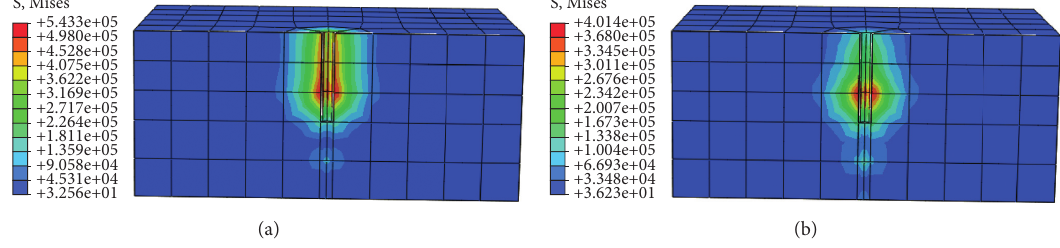
Figure 11: Mises principal stress (unit: MPa). (a) Before. (b) After.